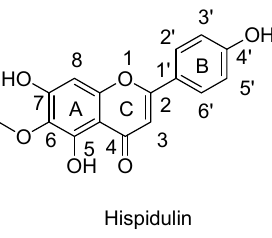
Figure 1. The chemical structure of hispidulin.